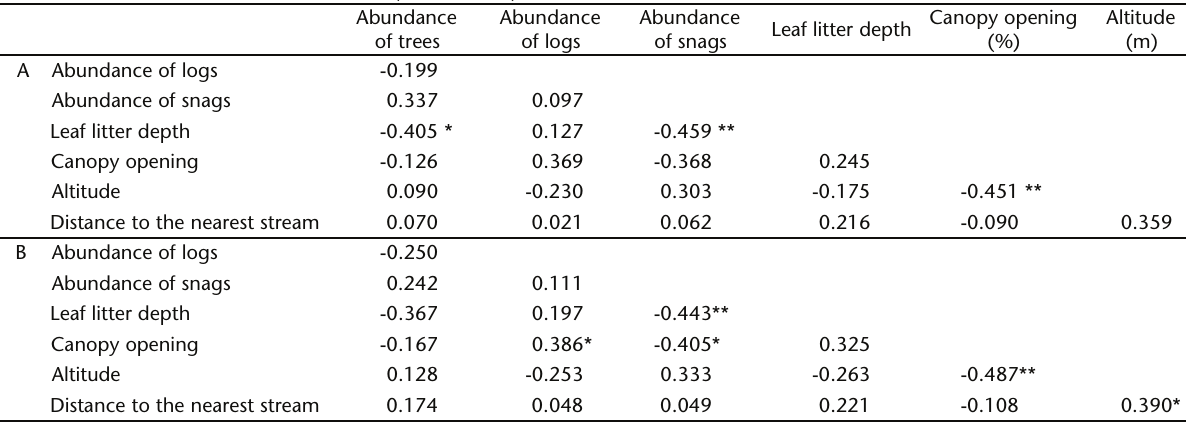
Table III. (A) Pearson correlation matrix for the forest structure components recorded in areas with M. watsonii along the 18 transects of 8 km length at Ducke Reserve, Central Amazon. (B) Pearson correlation matrix for the forest structure components recorded in 120 areas, 60 of them with and 60 without M. watsonii (see